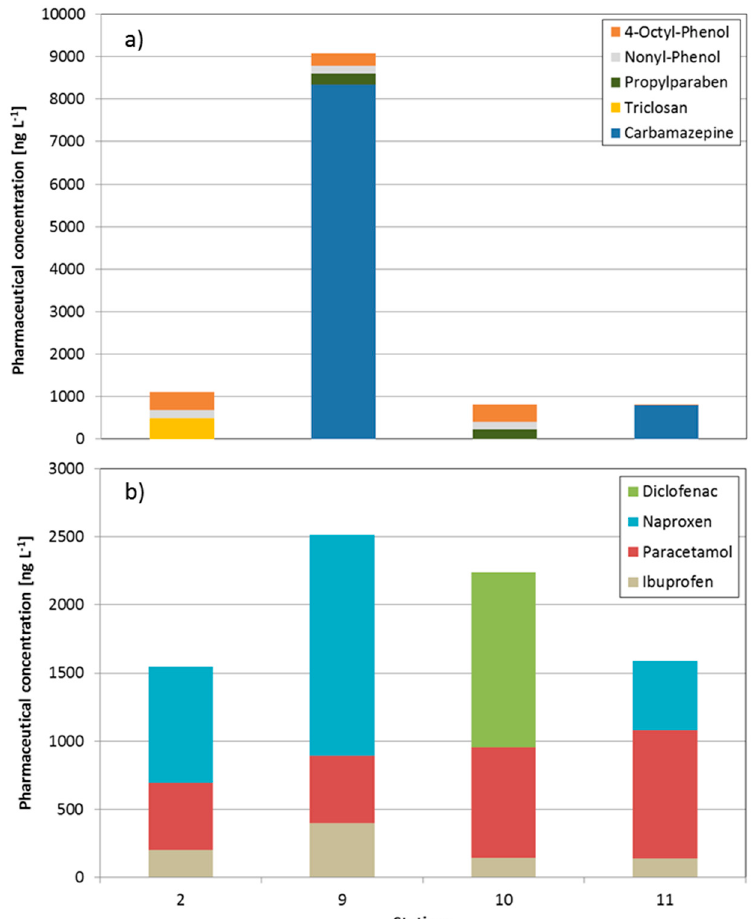
Figure 4. Most abundant pharmaceuticals found in water at five different stations of the Cauvery River. ( a ) Carbamazepine, triclosan, propyl paraben (preservatives), and phenol are essential for the production of polycarbonates, detergents, herbicides, and pharmaceutical drugs; ( b )